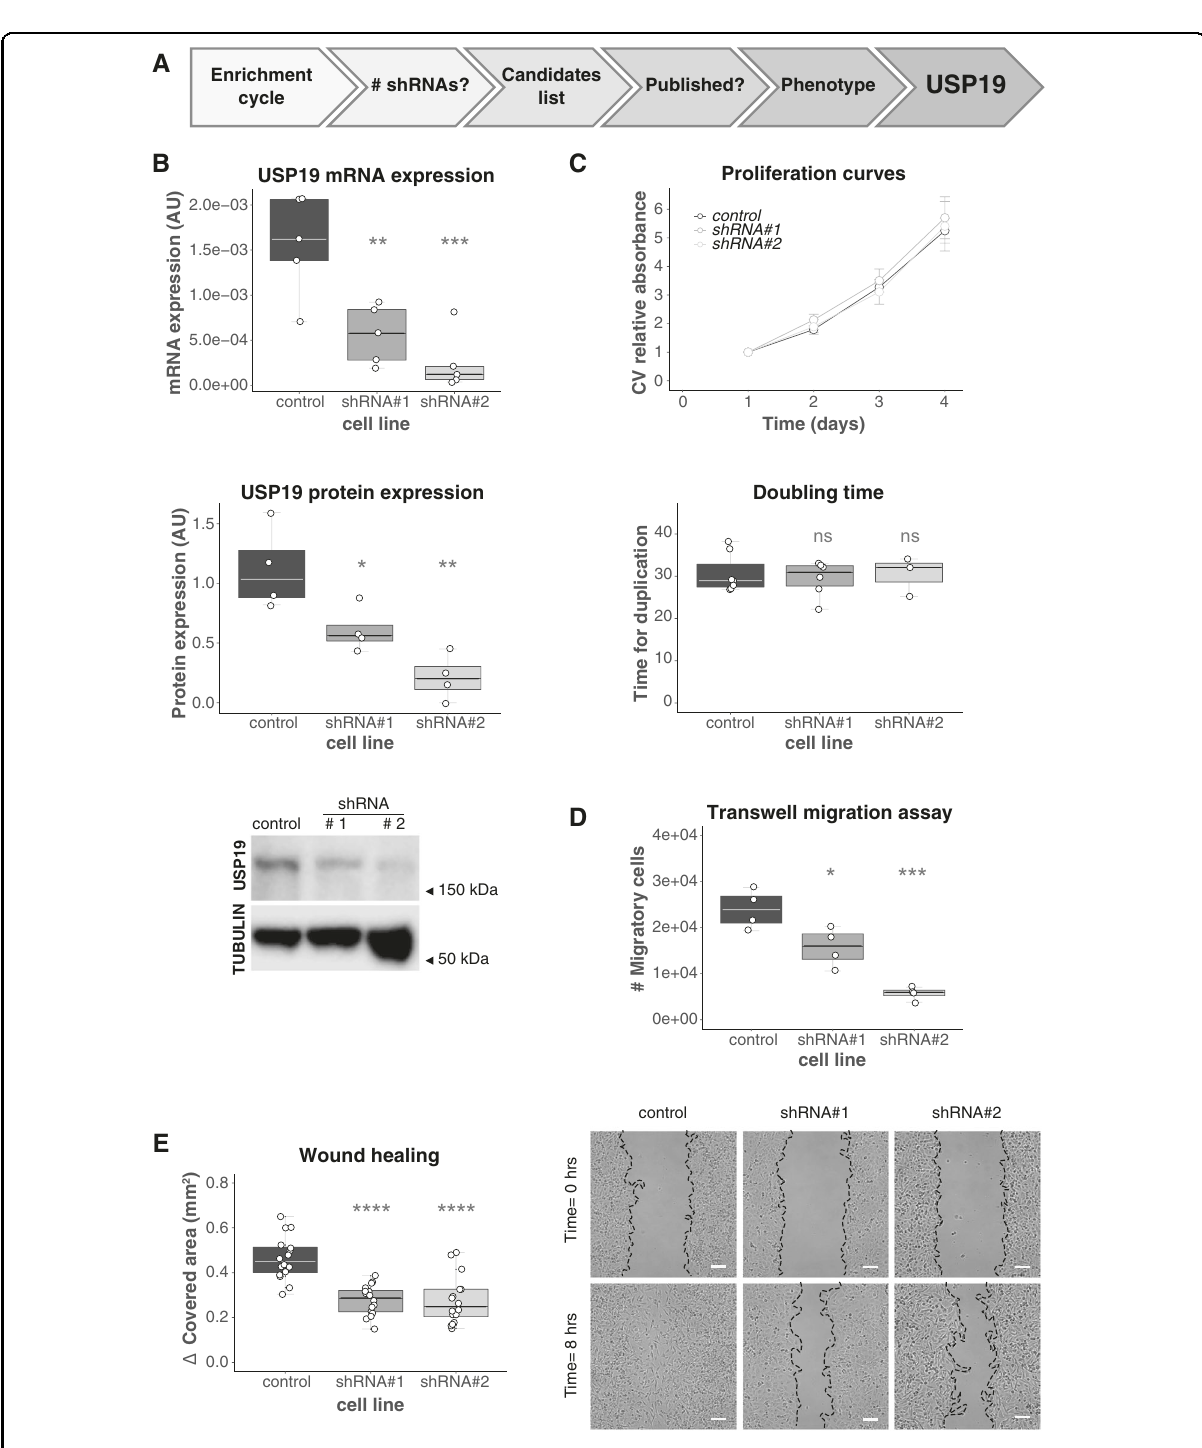
Fig. 1C, as enrichment cycles increased, we observed a marked reduction in the number of shRNAs, suggesting that the selection process was ef fi cient. As a control, we used an empty vector-transduced cell line.